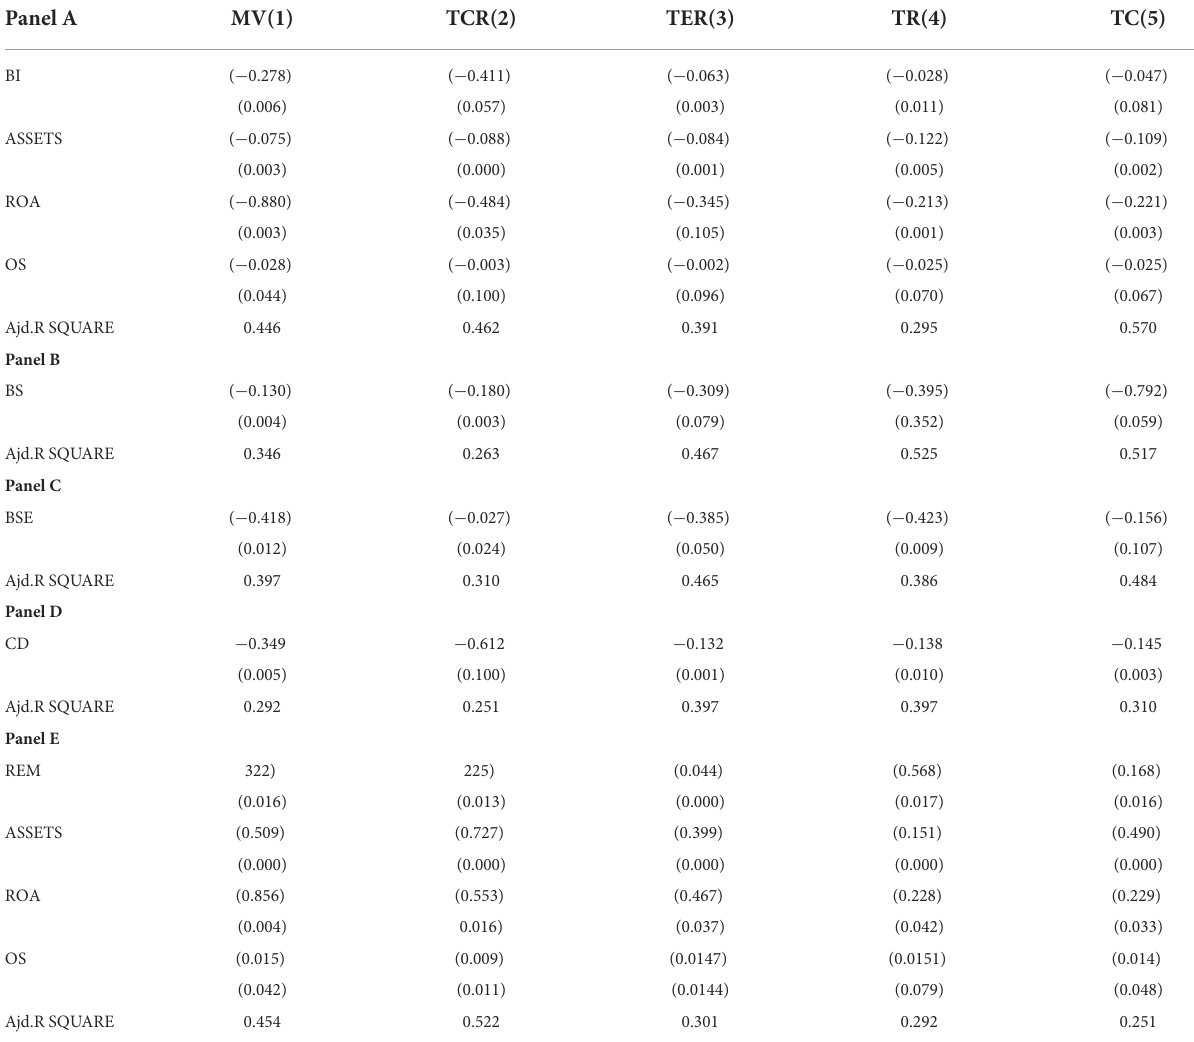
TABLE 3 Corporate governance CEO remuneration impact on bank capitalization